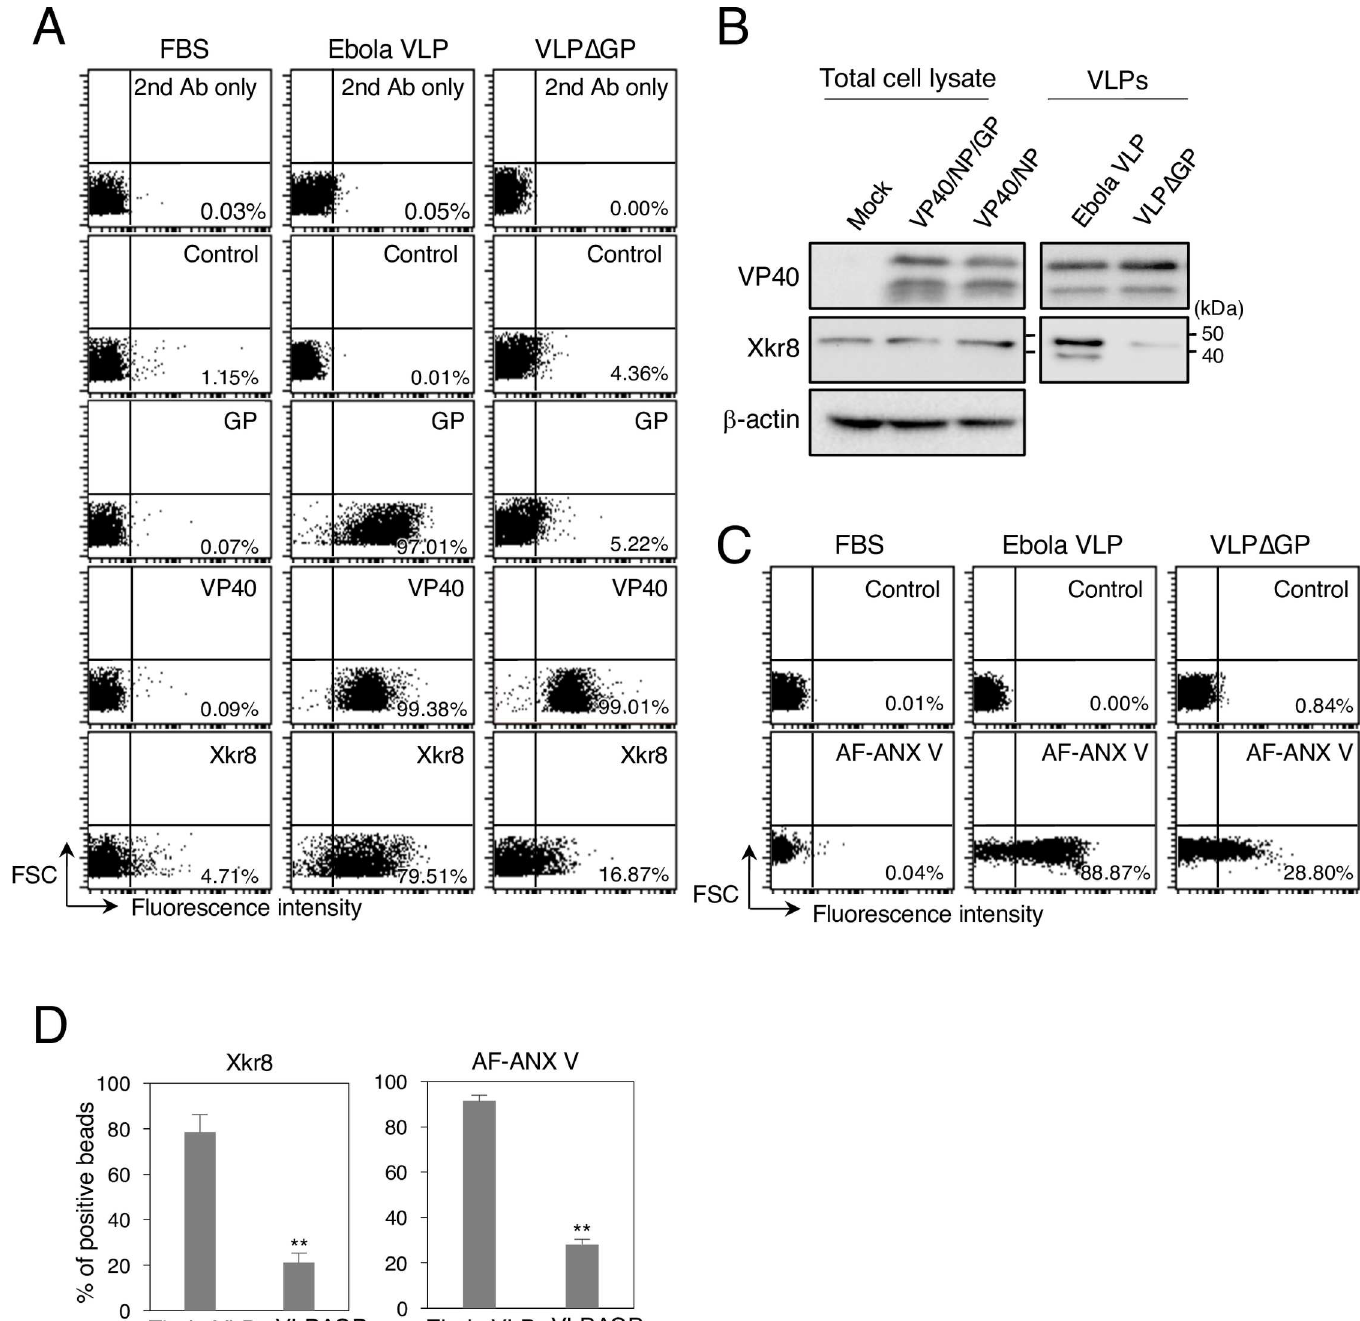
Fig 3. Role of GP in the incorporation of Xkr8 in Ebola VLPs. (A) Characterization of incorporated Xkr8 in Ebola VLPs by means of flow cytometry. FBS- (left), Ebola VLP- (middle), or VLP Δ GP- (right) conjugated beads incubated with the rabbit anti-VP40, GP, or Xkr8 polyclonal antibodies. For the binding of antibodies against VP40 and Xkr8, the beads were pre-treated with Triton X-100. 2 nd Ab indicates samples that were not treated with primary antibody. As a control, the rabbit anti-LASV GPC polyclonal antibody was used. The percentages of the positive populations are indicated. X-axis: fluorescence intensity, Y-axis: forward scatter corner signals. The results are representative of three individual experiments. (B) Characterization of incorporated Xkr8 in Ebola VLPs by western blotting. 293T cells were transfected with the expression plasmids of VP40 and NP, with or without GP. At 48 h.p.t., the cells and culture medium were harvested. Viral particles were purified from the culture medium. Total cell lysates and VLPs were analyzed by western blotting with the rabbit polyclonal antibodies against VP40, GP, Xkr8, or β -actin. (C) Binding of AF-ANX V to the beads. FBS- (left), Ebola VLP- (middle), or VLP Δ GP- (right) conjugated beads were incubated with AF-ANX V. The percentages of the positive populations are indicated. X-axis: fluorescence intensity, Y-axis: forward scatter corner signals. The results are representative of three individual experiments. (D) Summary of the binding of the anti-Xkr8 antibody (left) and AF ANX V (right) to the Ebola VLP- or VLP Δ GP-conjugated beads. Each experiment was performed in triplicate and the percentages of the positive populations are presented as the mean ± SD. (cid:3)(cid:3) , P < 0.01 versus respective control (Student’s t test). https://doi.org/10.1371/journal.ppat.1006848.g003 PLOS Pathogens| https://doi.org/10.1371/journal.ppat.1006848 January16,